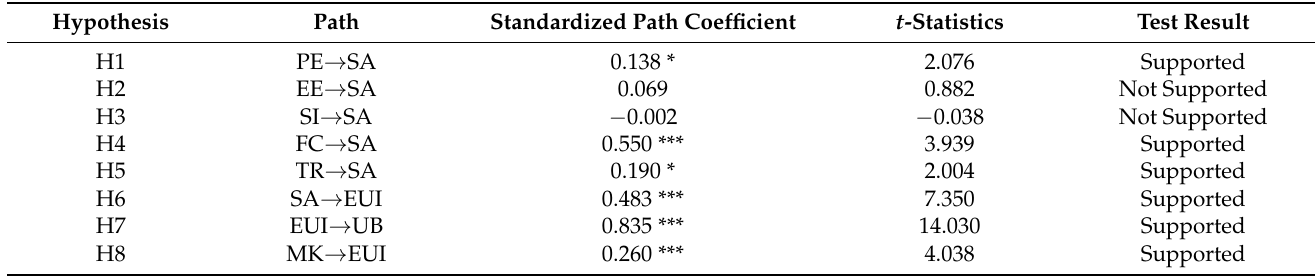
Figure 2. Results of the structural model. * p < 0.05, *** p < 0.001. Table 6. Hypothesis testing.